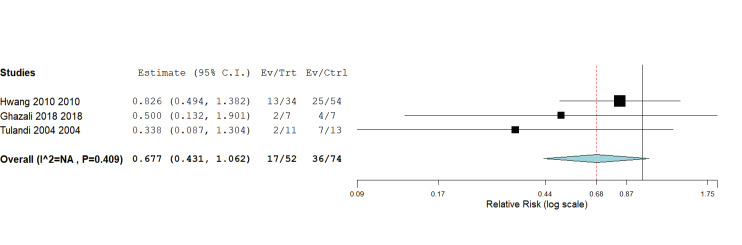
Blood Transfusion.